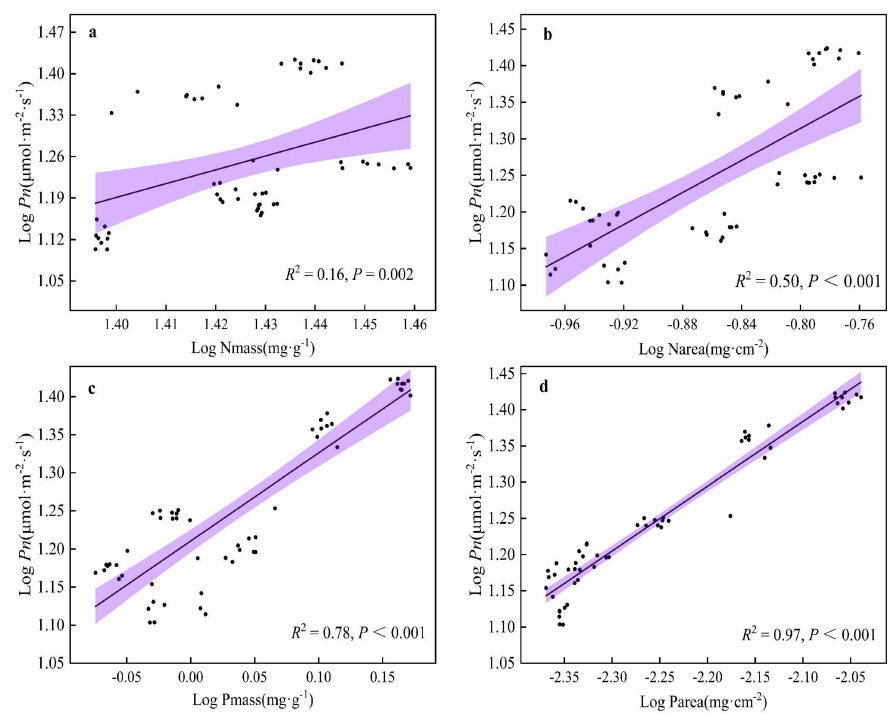
Figure 8. Linear regression relationship of Pn with other leaf functional traits. ( a ) Linear regression relationship between Nmass and Pn. ( b ) Linear regression relationship between Narea and Pn. ( c ) Linear regression relationship between Pmass and Pn. ( d ) Linear regression relationship between Parea and